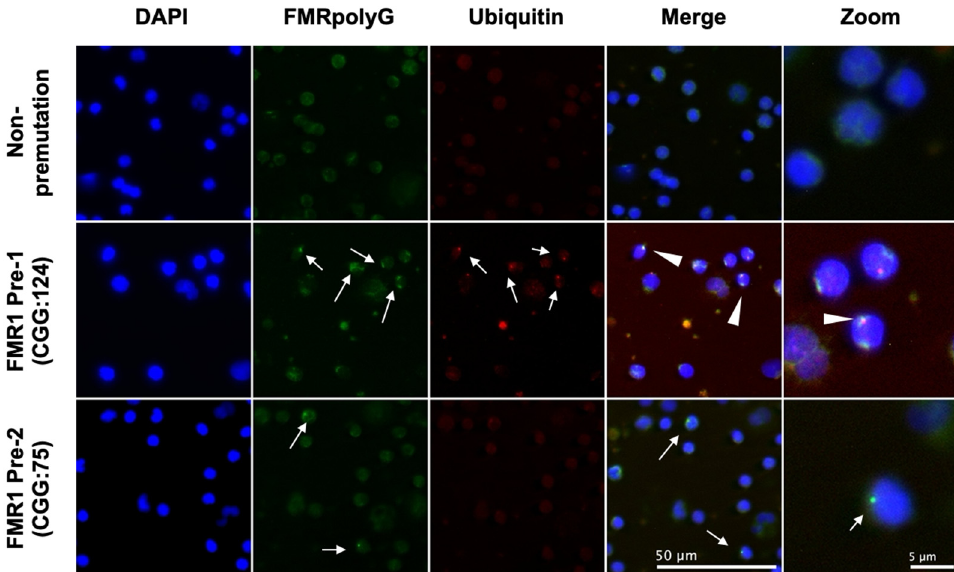
Figure 1. Fragile X mental retardation polyglycine (FMRpolyG) aggregates colocalized with ubiquitin in peripheral blood mononuclear cells (PBMCs) from FMR1 gene premutation carriers. Immunofluorescence (IF) staining of FMRpolyG and ubiquitin in PBMCs. Cells were fixed and stained with FMRpolyG and ubiquitin antibodies. Cell nuclei were stained with 4’,6-diamidino-2-phenylindole (DAPI), (blue). Alexa Fluor 488 (green) and Alexa Fluor 555 (red) were used as secondary antibodies for FMRpolyG and ubiquitin, respectively. White arrows indicate the colocalization of FMRpolyG and ubiquitin. Scale bar, 50 μ m.